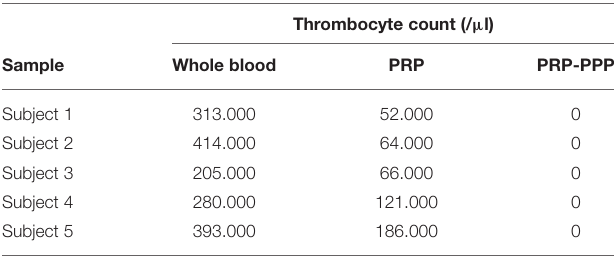
TABLE 2 | Thrombocyte count (per µ l) for whole blood, PRP, and PPP after preparation of